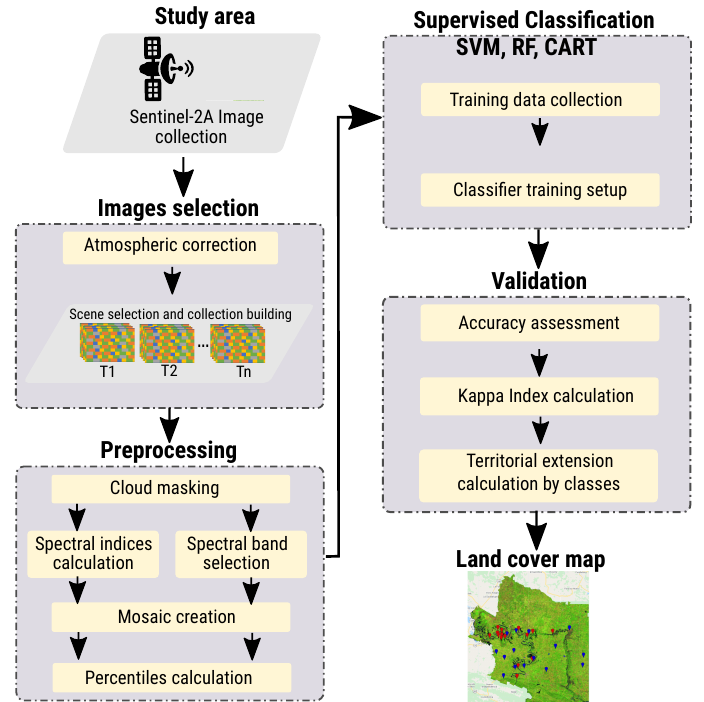
Figure 1. Proposed methodology for land-cover